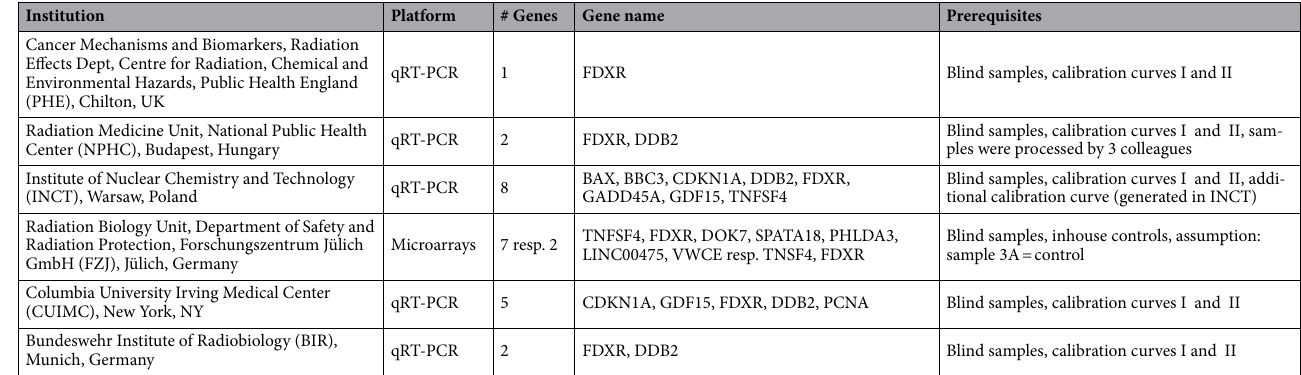
Table 1. Overview of participating teams, their institutions, and an overview of their contribution for the RENEB 2019 exercise comprising the platform used as well as the genes, calibration samples and further details.